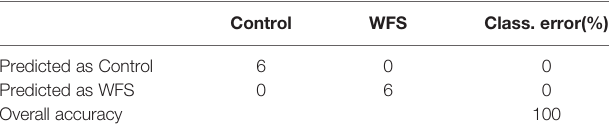
TABLE 4 | The predictive accuracy based on the 37-top biomarkers for white feces syndrome (WFS) using the random forests model. Control